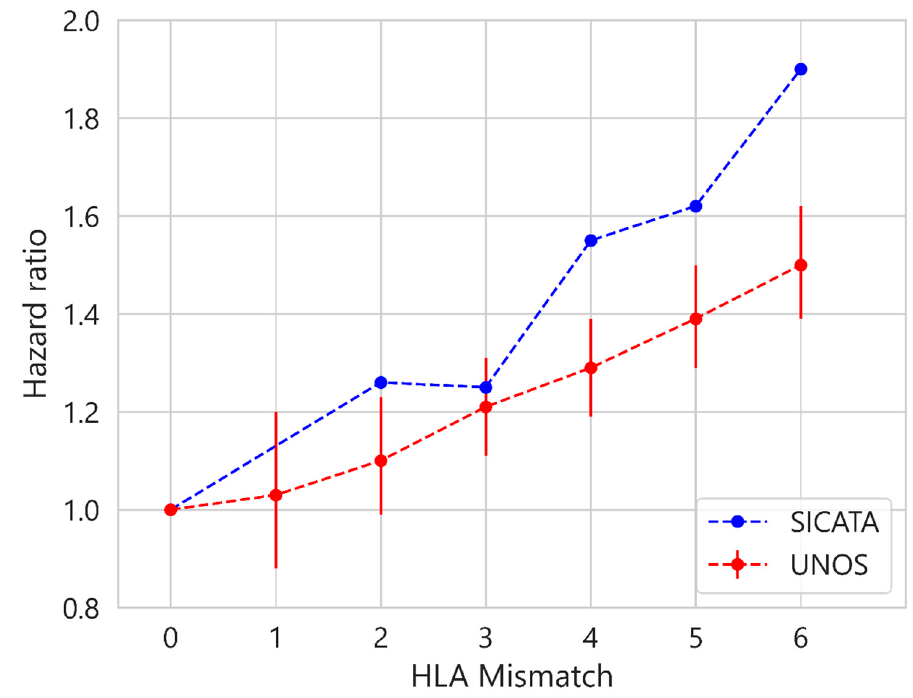
Figure 8. Hazard ratio for SICATA and UNOS at different levels of HLA incompatibilities.